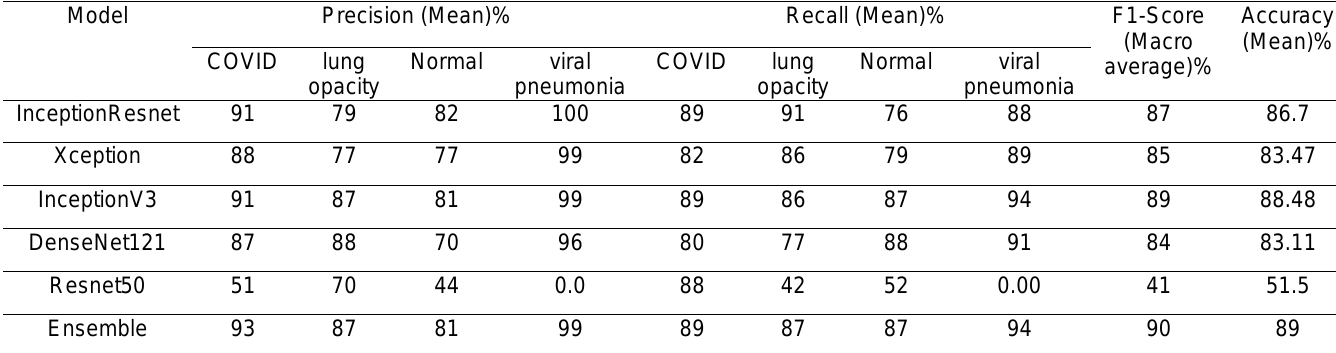
TABLE 1 X- RAY I MAGE C LASSIFICATION R ESULT